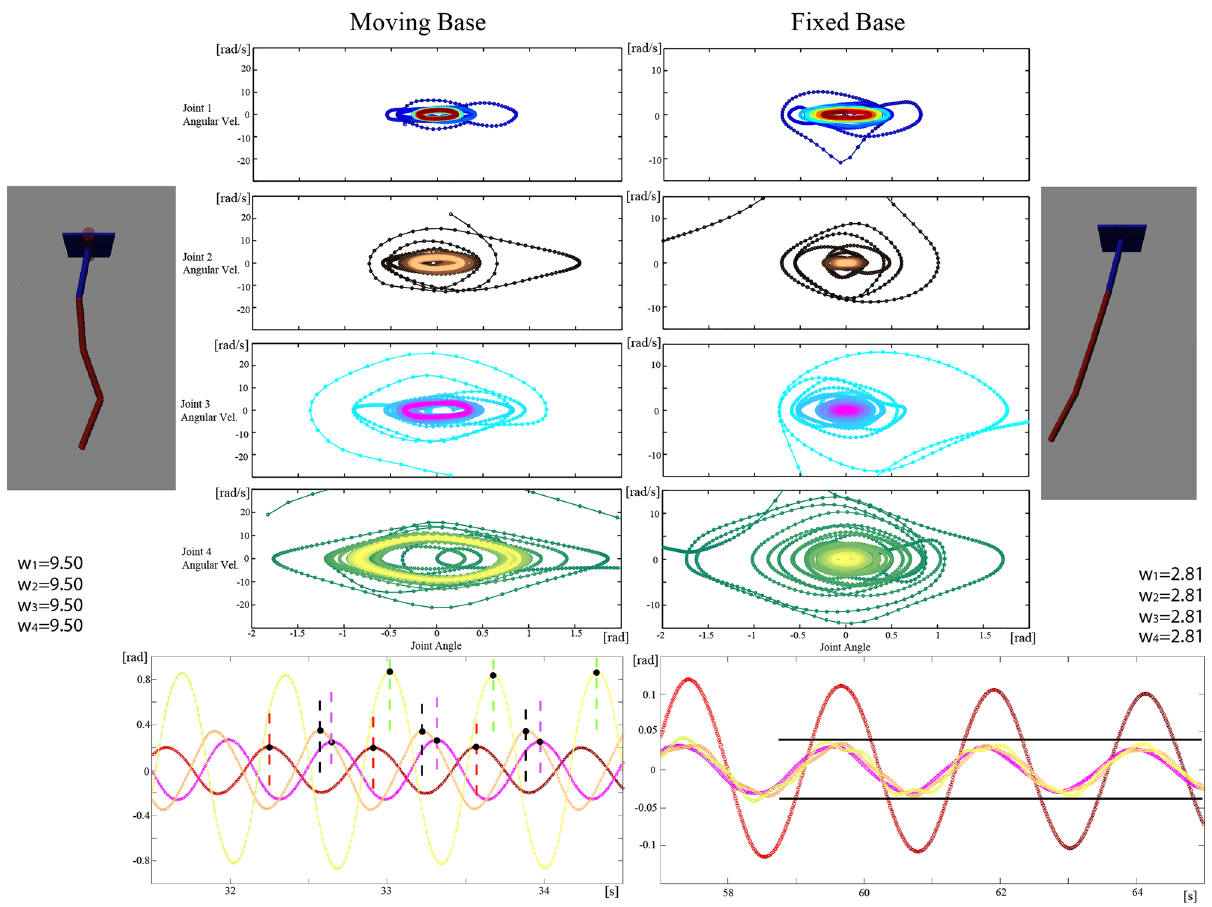
Figure 3. Joint angles of a four-segment pendulum in series. ( A ) The base link was a floating base. Coordinated motor patterns resulted in a synchronized frequency over all the joints. In the floating-base case, traveling wave coordination could be observed. ( B ) The base link was fixed. Here, in-phase coordination could be observed. The learning controller found synergetic coordination while adapting to the environment, without relying on neither the model information nor the coupled oscillator. Movie S4 shows the detailed process of how the limit cycle was formed. When the environmental situation allows, neural intergrator solution was converged into simple in-phase synergetic coordination with the same amplitude as in the fixed base result. The amplitude, frequency, and phase modulation then appear in the moving base to sustain the oscillation as the total system oscillation can not be managed when the oscillation amplitude is same over the